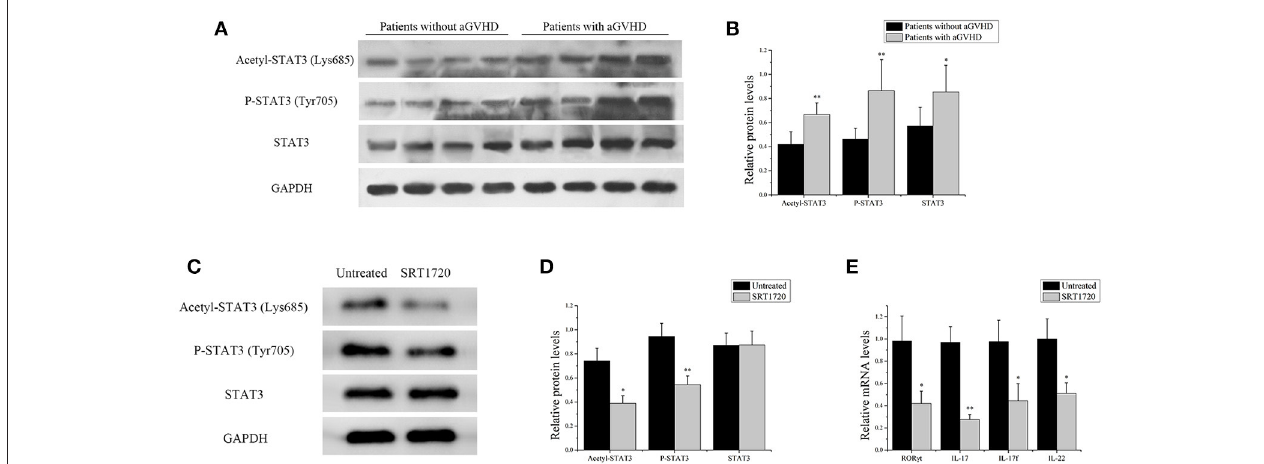
FIGURE 4 | SIRT1 deficiency in CD4 + T cells from patients with aGVHD promoted Th17-related gene expression. (A) acetyl-STAT3 (Lys685), P-STAT3 (Tyr705), and STAT3 total protein levels in CD4 + T cells from patients with aGVHD ( n = 10) and patients without aGVHD ( n = 10) were detected by Western blotting. (B) Quantitative analysis of the band intensities for acetyl-STAT3 (Lys685) and P-STAT3 (Tyr705) normalized by STAT3 total protein levels, STAT3 total protein levels normalized by GAPDH. (C,D) Representative western blotting results (C) and quantitative analysis (D) of the band intensities for acetyl-STAT3 and P-STAT3 in CD4 + T cells from patients with aGVHD treated or not with the SRT1720. (E) mRNA levels of ROR γ t, IL17, IL17f, IL-22 in CD4 + T cells from patients with aGVHD treated or not with SRT1720. Data are presented as the mean ± SD of the same experiments performed in three aGVHD patients. * p < 0.05, ** p < 0.01.